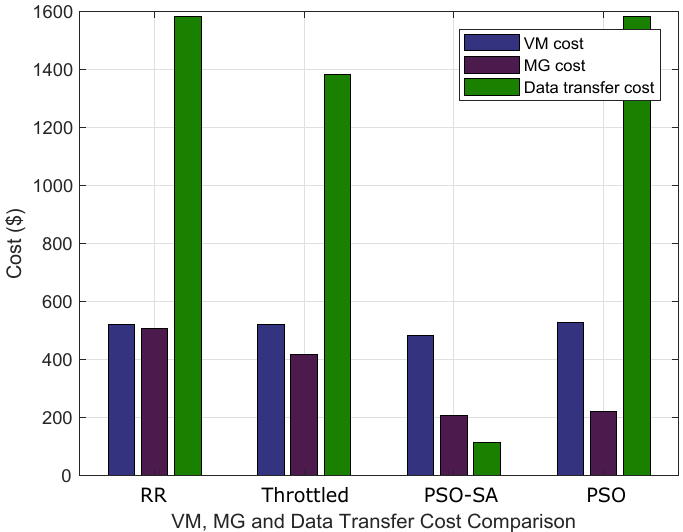
Figure 5. Overall Cost Comparison in Scenario